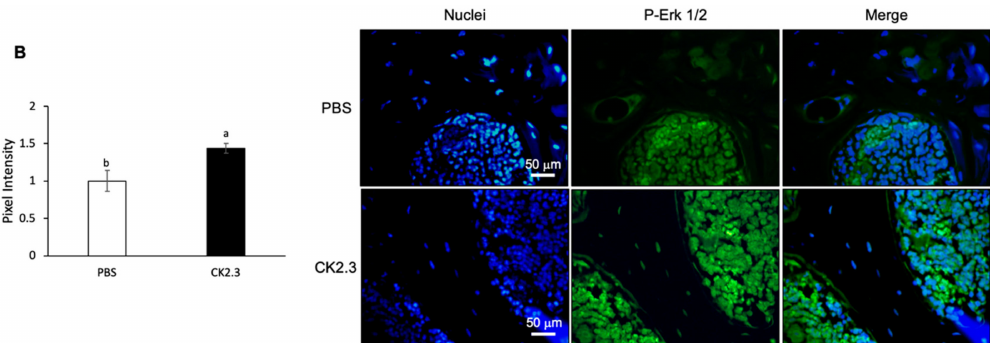
Figure 10. Uptake period and regulation of p-Erk1 / 2 by CK2.3 in the femurs of 6-month-old retired breeder mice. ( A ) 2 weeks after the injection, CK2.3 uptake was detected in the femurs of 6-month-old retired mice by immunofluorescence. ( B ) Increased p-Erk1 / 2 was detected by immunofluorescence in the femurs of 6-month-old retired breeder mice at Week 2 after the injection. a: denotes significant di ff erence from PBS, and b: denotes significant di ff erence from CK2.3